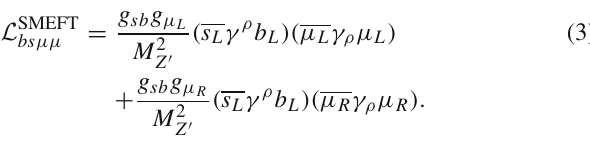
Table1 U ( 1 ) F chargesofthefieldsintheoriginalThirdFamilyHyper- charge Model (TFHM), where i ∈ { 1 , 2 } . All gauge anomalies, mixed gauge anomalies and mixed gauge-gravity anomalies cancel. Under the SM gauge symmetry SU ( 3 ) × SU ( 2 ) L × U ( 1 ) Y , the fields transform as H ∼ ( 1 , 2 , − 1 / 2 ) , Q i (cid:2)